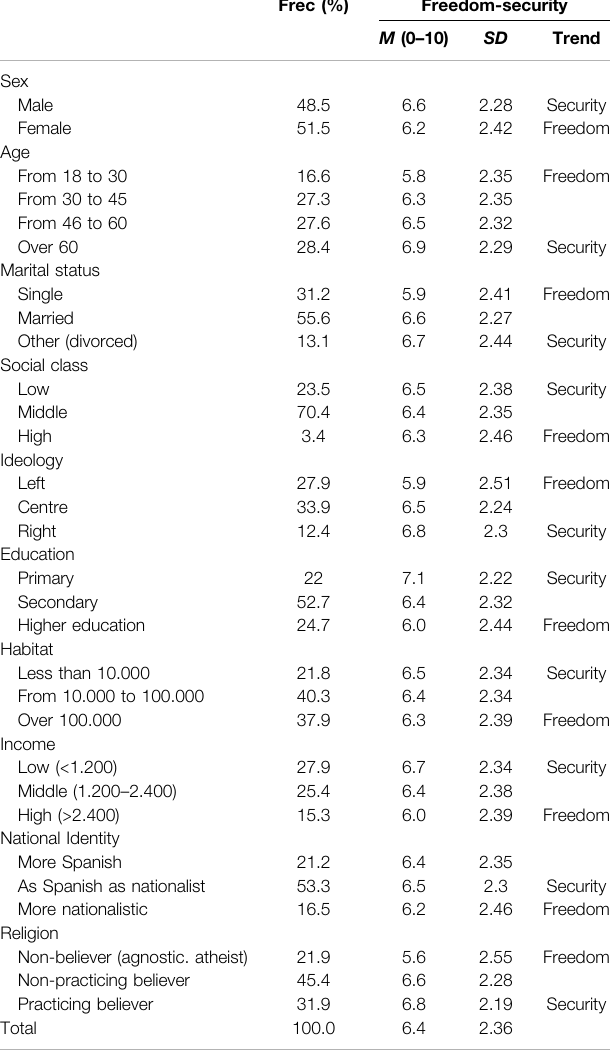
TABLE 2 | Descriptive and sociodemographic pro fi